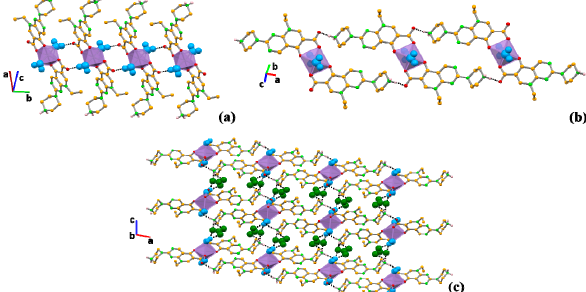
Figure 5. Supramolecular arrangements depicting ( a ) the hydrogen-bonded chains formed by the interaction between the water molecules and pipemidic acid; ( b ) the hydrogen bonds established between pipemidic acid in consecutive complexes; ( c ) the three-dimensional (3D) framework. Hydrogen atoms not involved in hydrogen bonds have been omitted for clarity; using spacefill style, water molecules are represented in blue and nitrate anions are represented in dark green.